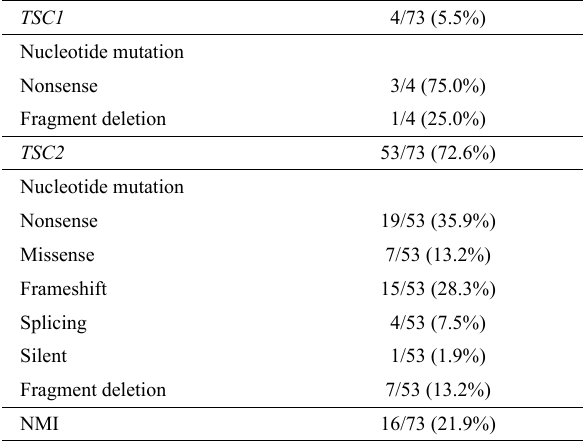
Table 1 - TSC1 and TSC2 mutations in the 73